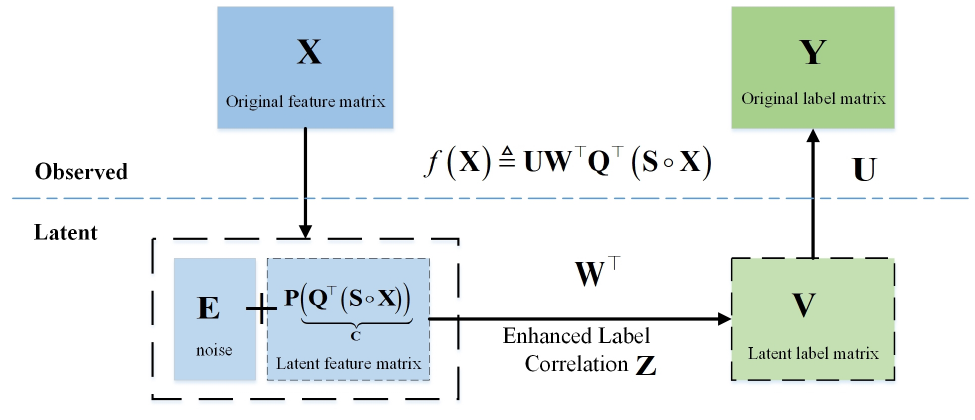
Figure 1. Framework of RGLC. Instead of directly learning global and local label correlations Z from the observed feature matrix X to observed label matrix Y , we attempt to train the RGLC (i.e., f ( X ) ) model from latent feature matrix (i.e., C (cid:44) Q (cid:62) ( S ◦ X ) ) to latent label matrix (i.e., V ). It exploits global and local label correlations Z on latent features and labels with linear mapping W (cid:62)